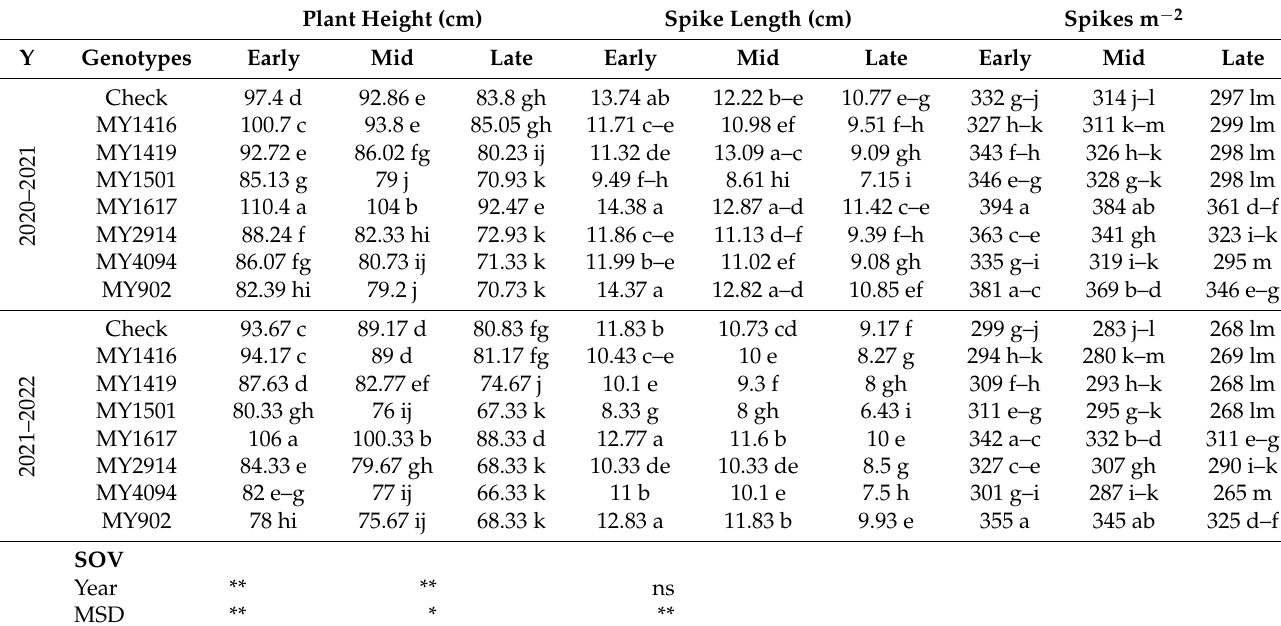
Table 5. Plant height (cm), spike length (cm), and spike m − 2 of different wheat genotypes